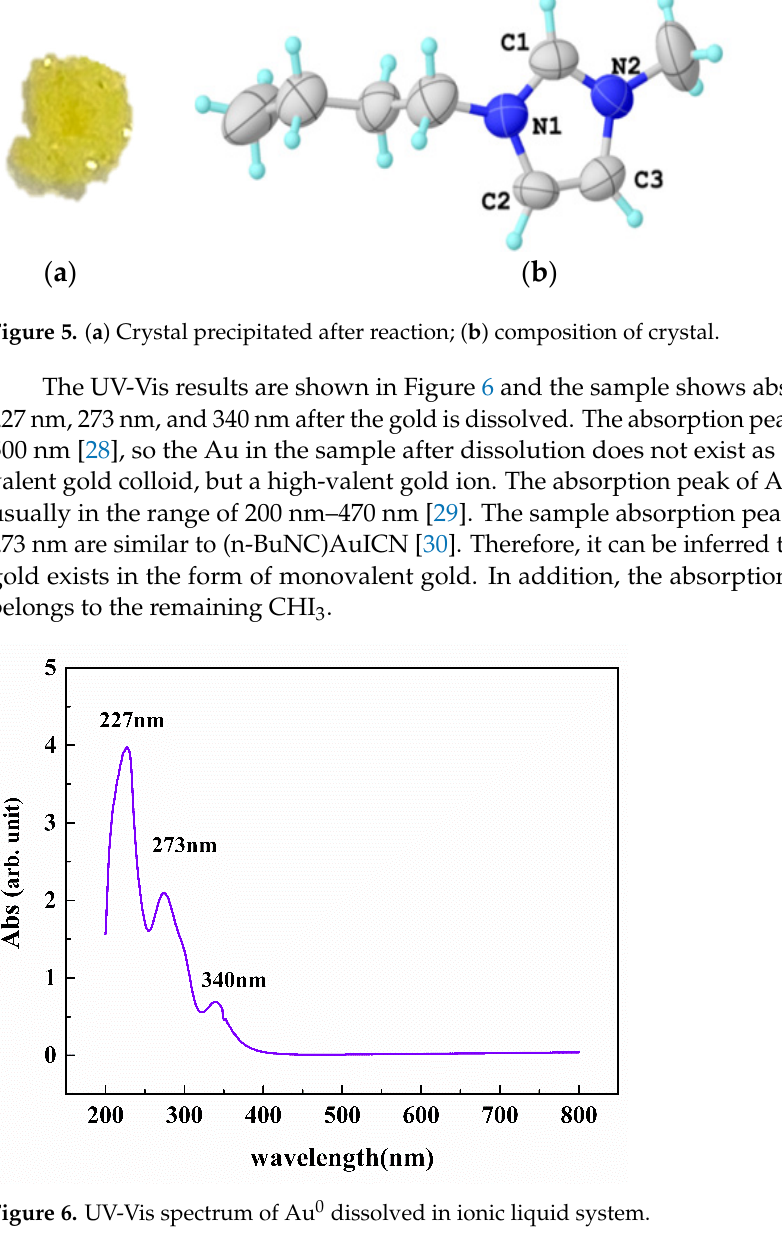
Figure 6. UV-Vis spectrum of Au 0 dissolved in ionic liquid system.